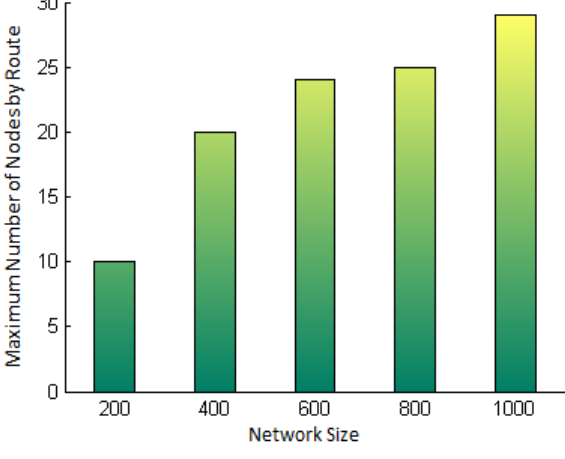
Figure 11. Maximum number of hops to the base station, for different network sizes.